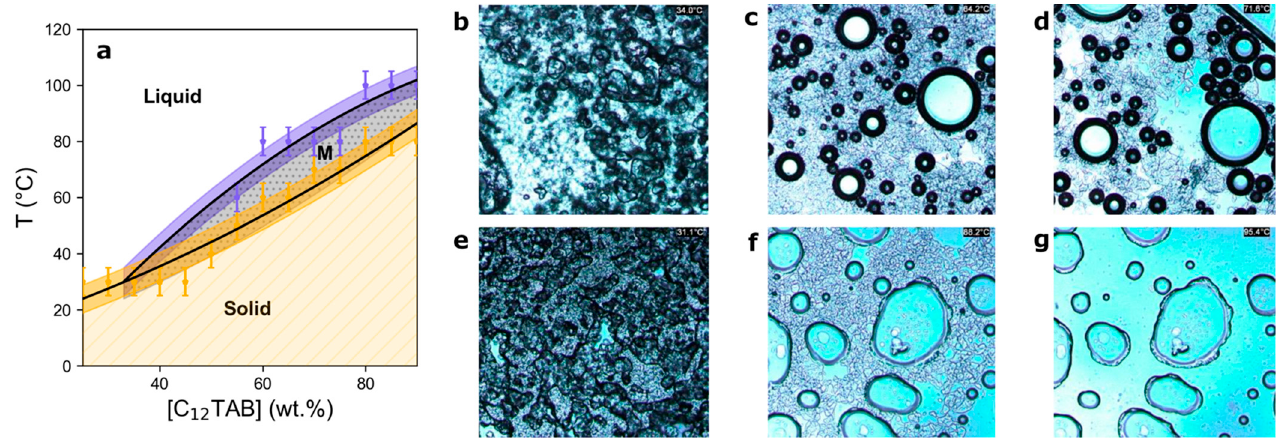
Figure 2. ( a ) Phase diagram generated by interpolating datapoints from visual inspection of C 12 TAB in 1:2 choline chloride:ethylene glycol eutectic mixtures at varying compositions and temperatures. The pale-yellow dashed area (bottom) shows compositions where samples contained solids. The grey dotted area marked ‘M’ denotes the possible mesophase region, with the dark shaded coloured regions showing the associated uncertainties (±5 °C) arising from the temperature sampling interval. The clear region shows the compositions at which the samples were transparent and isotropic. ( b – g ) Hot-stage optical microscopy of ( b – d ; top row) 70 wt.% C 12 TAB in 1:2 choline chloride:ethylene glycol at 34.0 °C ( b ), 64.2 °C ( c ), and 71.6 °C ( d ), and of ( e – g ; bottom row) 80 wt.% C 12 TAB in 1:2 choline chloride:ethylene glycol at 31.1 °C ( e ), 88.2 °C ( f ), and 95.4 °C ( g ).